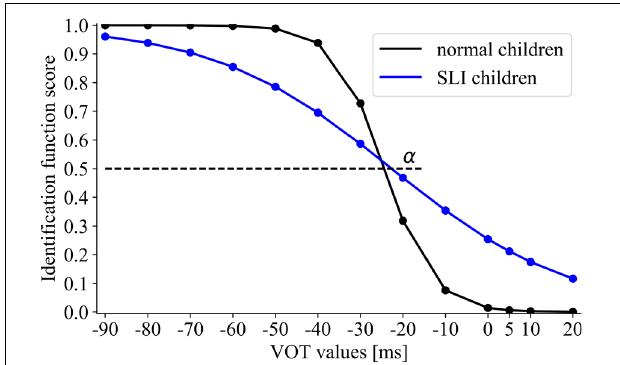
FIGURE 5 | The sigmoid function for NC and specific language impairment (SLI) groups. The boundary location ( α ) corresponds to the VOT value at which 50% of voiced/unvoiced identifications were